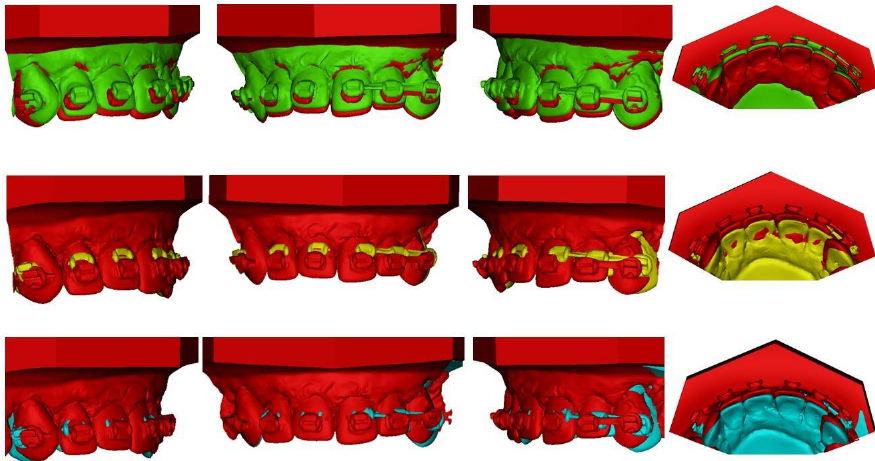
Figure 16. Superimpositions of typodonts in 10 mm cantilever activation: UA6 (red: T0, green: T1): intrusion and protrusion observed, TB (red: T0, yellow: T1): intrusion and retrusion observed DC (red: T0, blue: T1): intrusion and retrusion; retrusion more pronounced for DC than for TB.